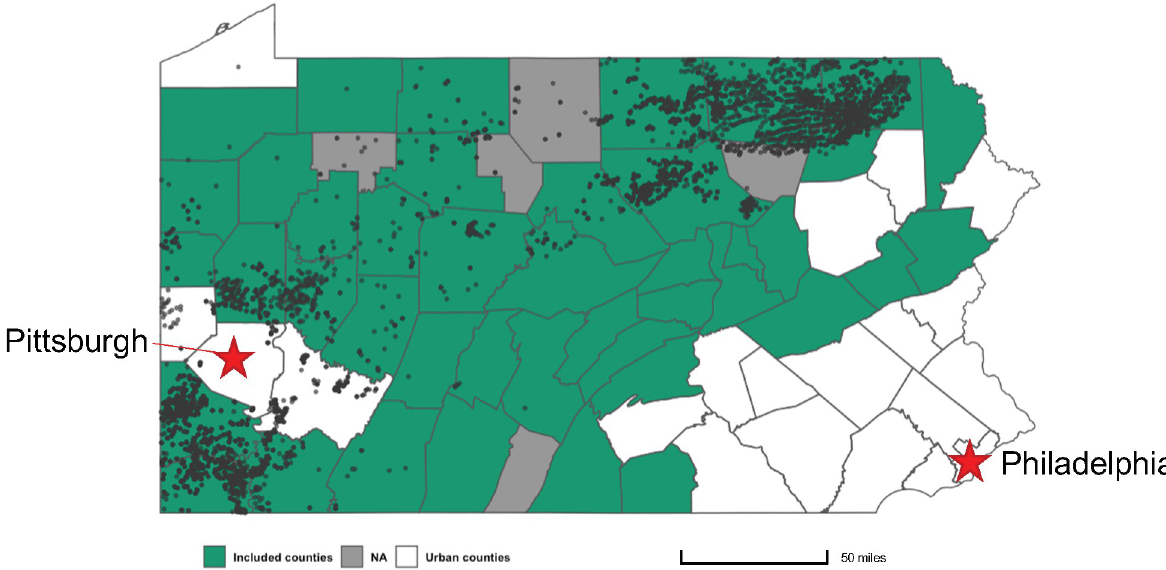
Fig 3. Pennsylvania counties included for regression model optimization. Active UNGD wells spudded through the end of 2014 shown by grey circles. The color designation of counties are as follows: green indicates rural counties that were included, grey indicates counties that lack or do not display asthma HAR for all years of interest, and white indicates urban counties that were excluded.